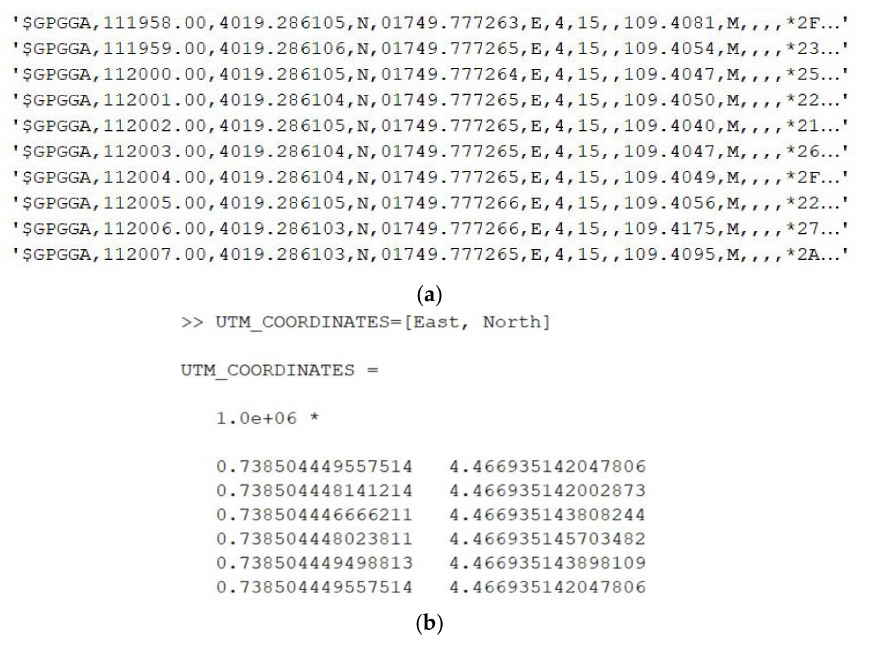
Figure 13. NMEA messages acquired by the VBOX sensor, filtered by the developed Matlab script ( a ), and converted into UTM coordinate ( b ).